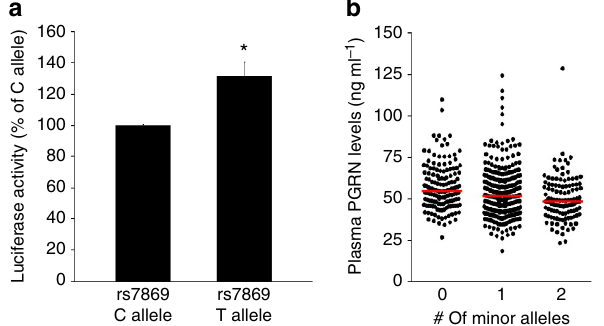
Figure 2 | Functional analysis of rs7869-dependent regulation of PSAP and PGRN levels. ( a ) Luciferase activity quantification in HeLa cells transfected with either pMir-REPORT-rs7869C or pMir-REPORT-rs7869T constructs. Graphed values represent the mean ± s.e.m. and are expressed as a percent of pMir-REPORT-rs7869C luciferase activity ( n ¼ 13 per group). ( b ) Scatter plot representing plasma PGRN levels in individuals within our initial series expressing the different rs7869 genotypes. Red horizontal lines represent the median plasma PGRN value of each